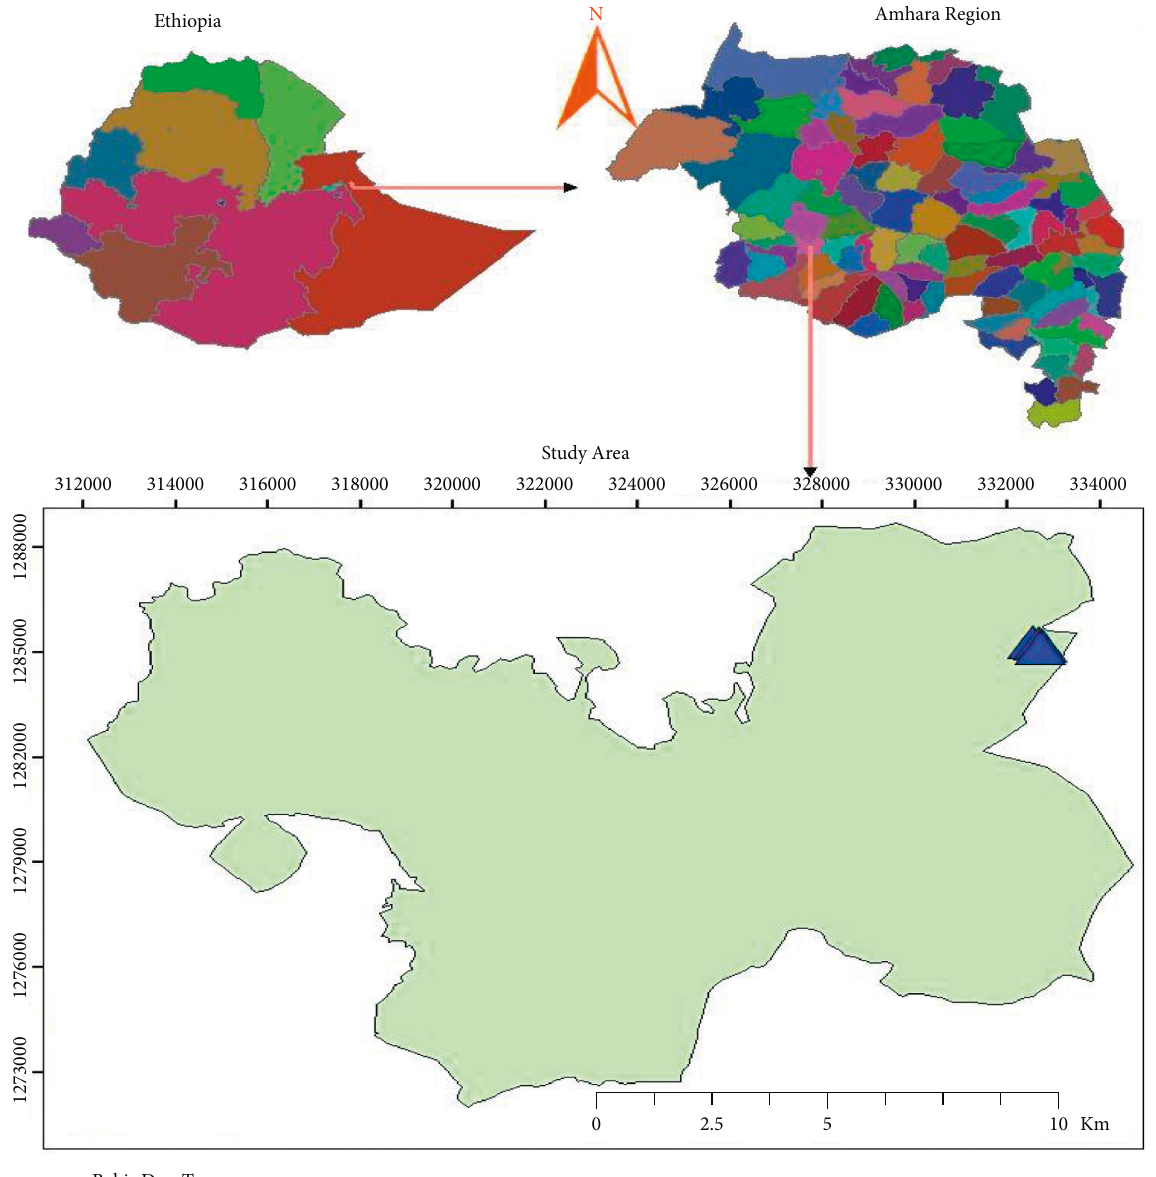
Figure 1: Location map of the study